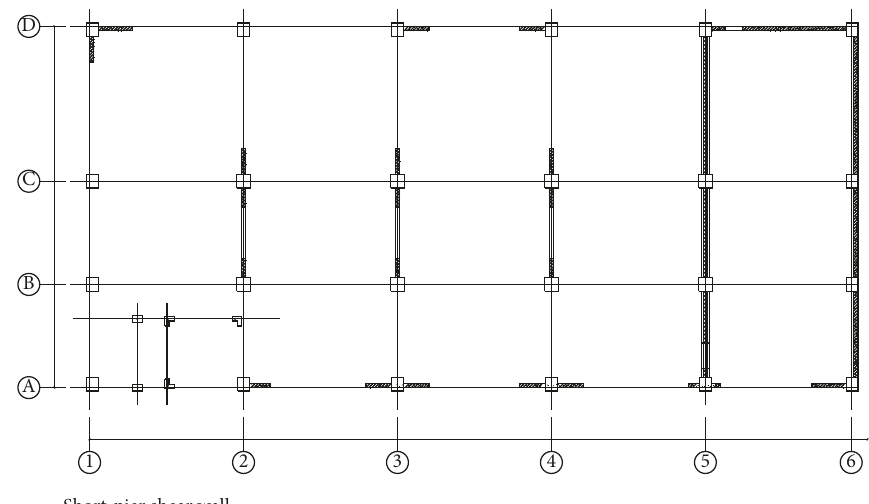
Figure 8: Part of the short-pier shear wall